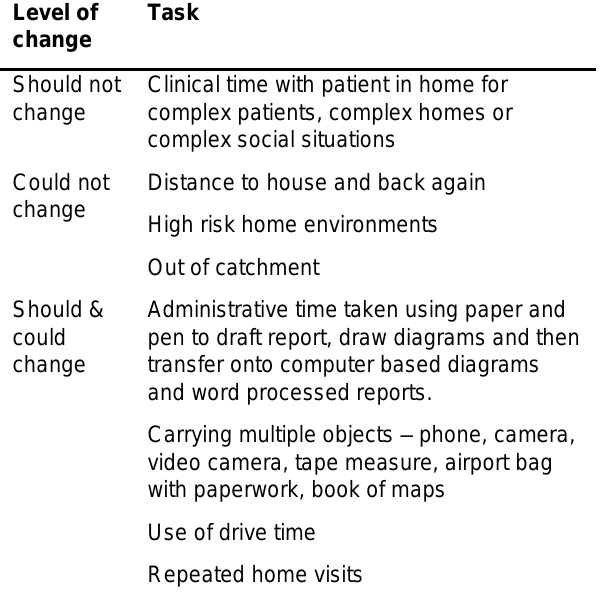
Table 1. Process Review Outcomes